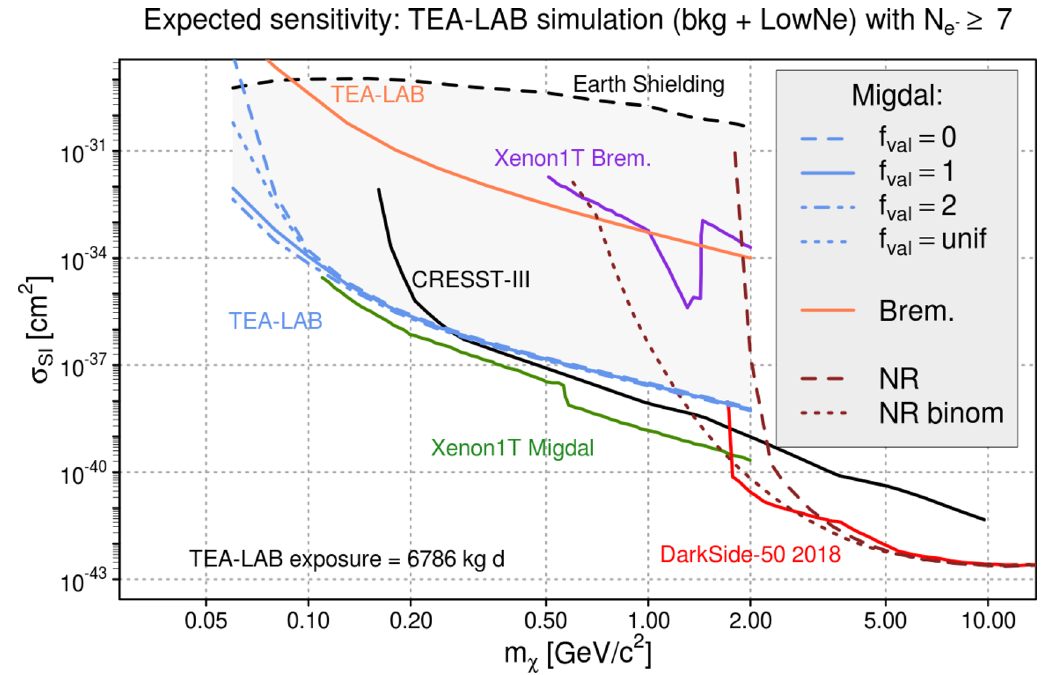
Figure 6 . 90% C : I : upper bounds on the (cid:27) SI exploiting the Migdal electron and photon Bremsstrahlung signals for the tea-lab simulated experiment loosely inspired by DarkSide-50. These results are obtained using and exposure E = 6786 kg d , and simulating a pseudo-dataset with the background-only template, including the LowNe excess (see section 3.2, 3.1). The tea- lab bounds are computed for a threshold N = 7 . Different Migdal electron signal uncertainties e (cid:0) are considered (see section 3.2.2): f val = 0 corresponding to no valence shell contribution (blue dashed line), f val = 1 (blue line), f val = 2 (dashed-dotted line), and f val treated as a nuisance parameter with a uniform prior p.d.f. in [0 ; 2] . The tea-lab bound for the photon Bremsstrahlung signal is reported (orange line). The estimate of the Earth shielding effect for tea-lab is also reported (black dashed curve). The gray shaded area, has to be intended as the region where